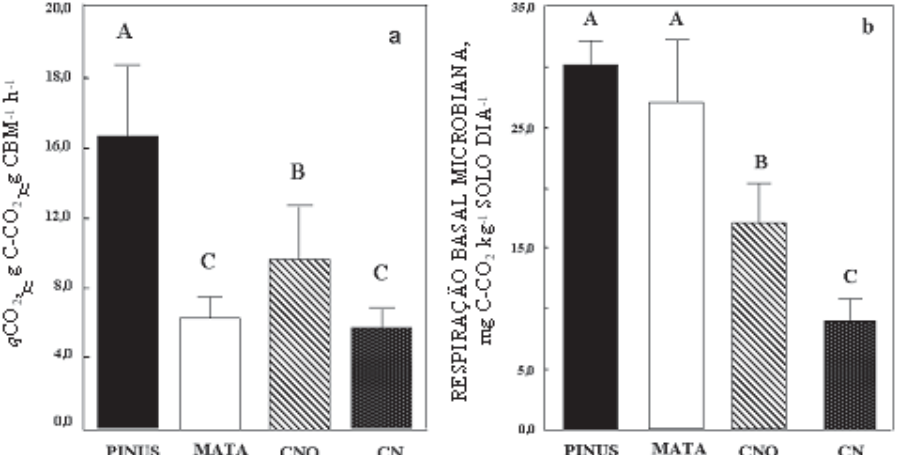
Figura 3. Valores de q CO (a) e respiração basal microbiana (b), em quatro tratamentos de manejo de 2 solo na região de Lages (SC). Letras diferentes, em cada tratamento, indicam diferença significativa pelo teste de Duncan a 5 %. CN: campo nativo; CNQ: campo nativo submetido à queima; PINUS: monocultivo de Pinus taeda ; MATA: mata natural com predominância de Araucaria angustifolia